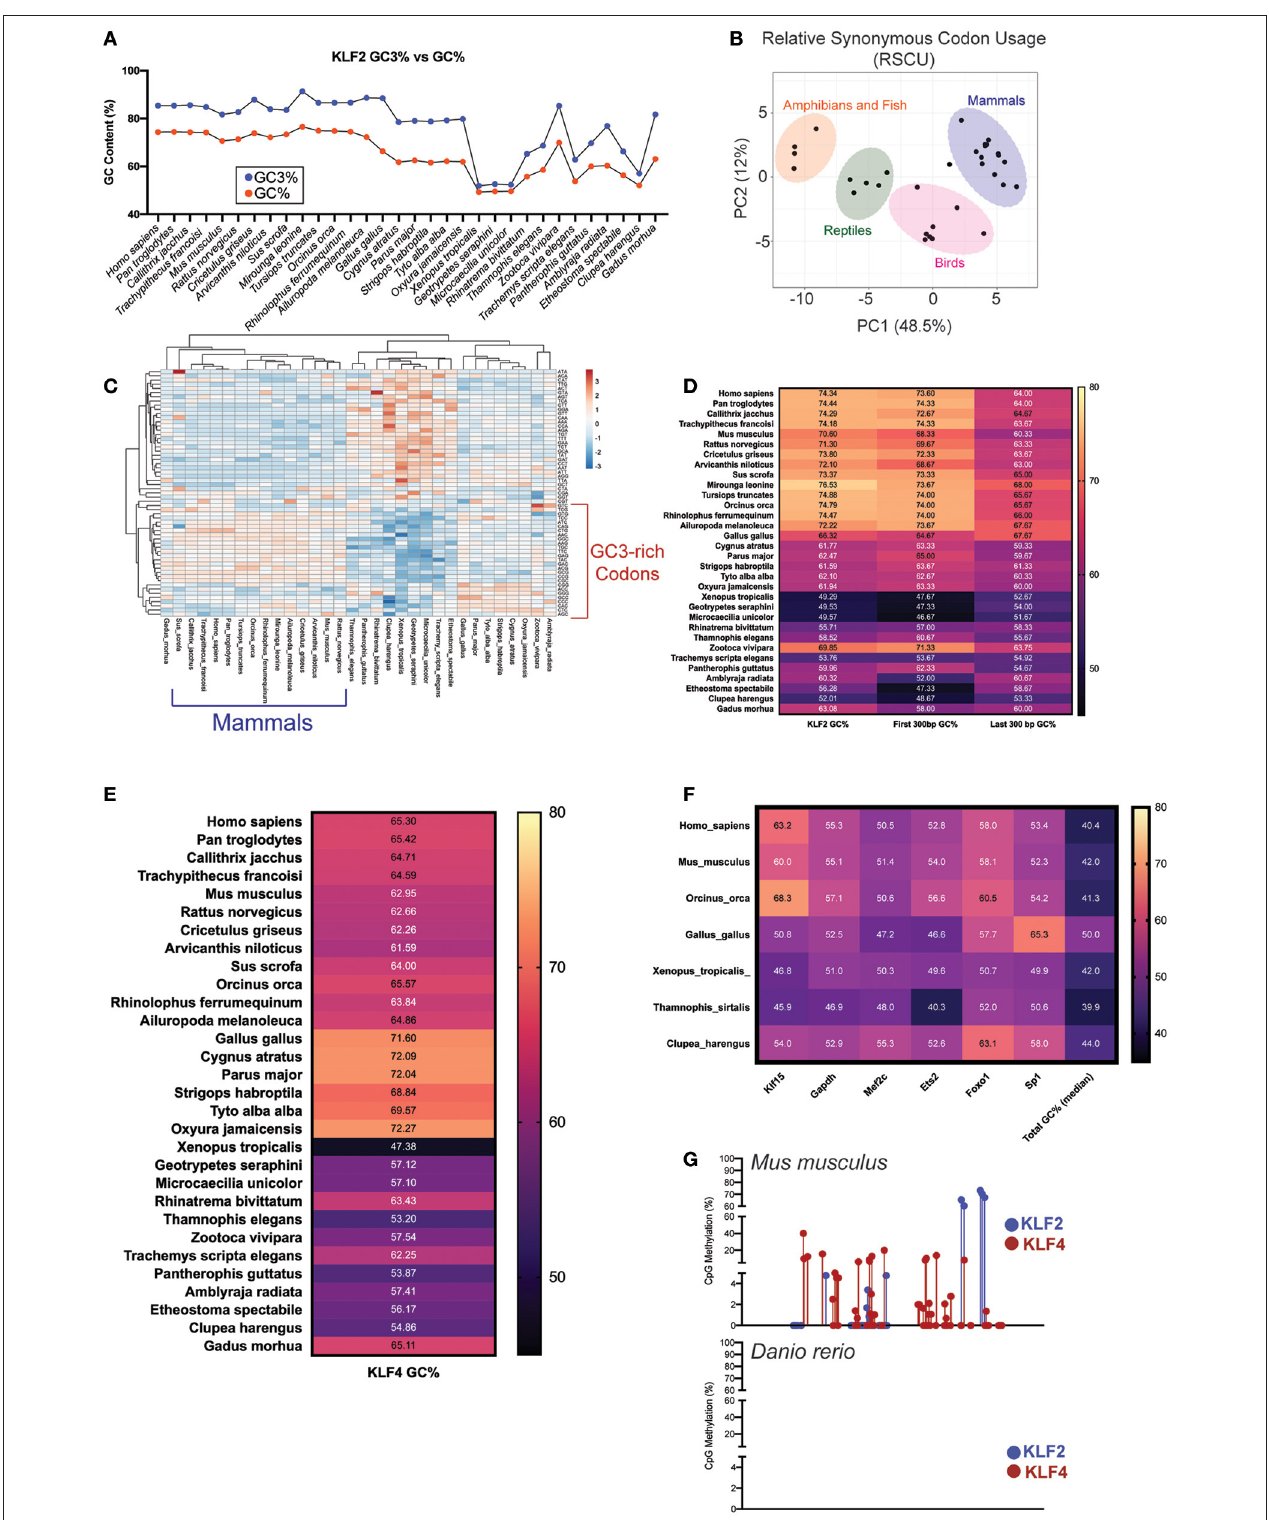
FIGURE 2 | (A) Comparison of GC% to GC3% (G/C positioned in the 3rd base of a codon) in KLF2 across multiple species. (B) Principal Component Analysis (PCA) for KLF2 Relative Synonymous Codon Usage (RSCU) across numerous species. Variance largely clustered by class as delineated by color-coded ovals. (C) Heatmap of KLF2 RSCU for each species. Intensity of color corresponds with relative utilization of a particular nucleotide combination for a codon. Unsupervised clustering